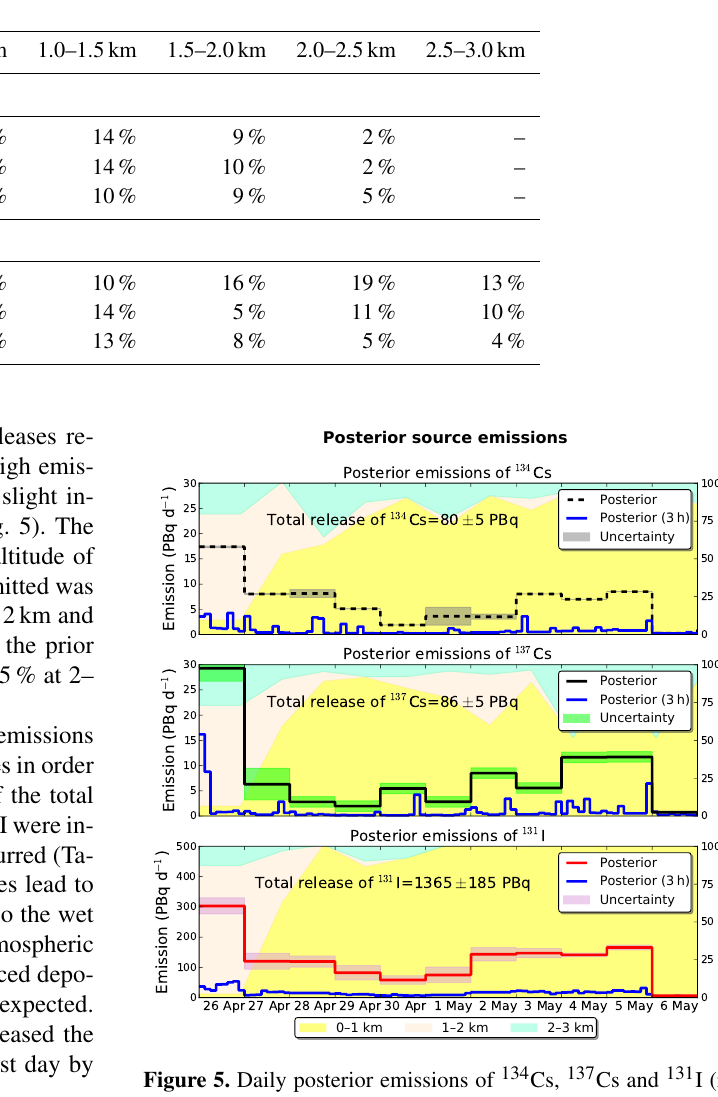
Table 1. Injection altitude (% of total released mass) of prior and posterior emissions of 134 Cs, 137 Cs and 131 I averaged over the 12-day period from 26 April 1986 until 7 May 1986.